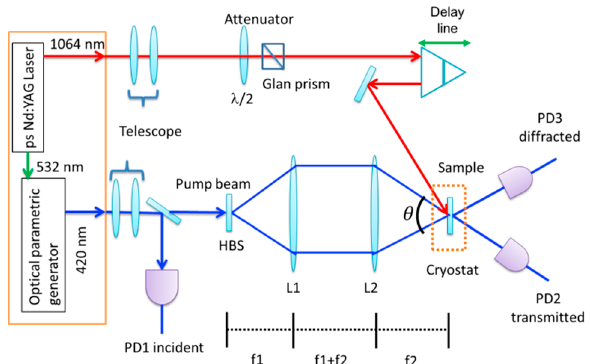
Figure 2. Optical scheme of nondegenerate four-wave mixing (FWM) with holographic spectroscope (HBS) as beam splitter.